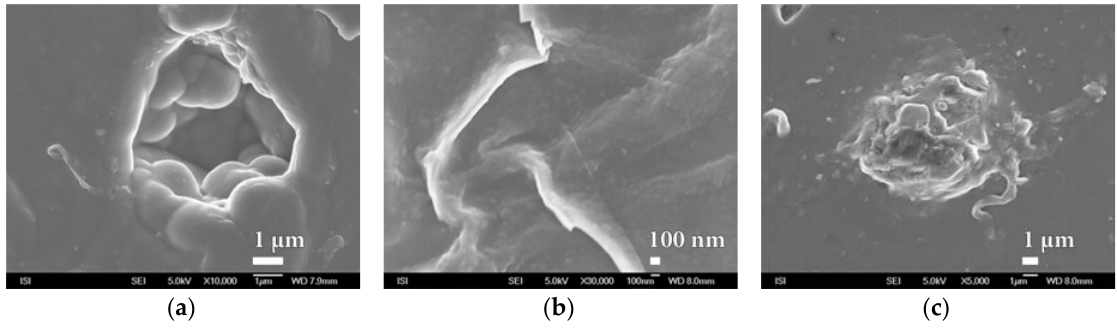
Figure 7. The exhibitions of different inhomogeneity on the surface of the used polymer foil PEVA at various magnifications of ( a ) 10,000×; ( b ) 30,000×;( c ) 5000×.